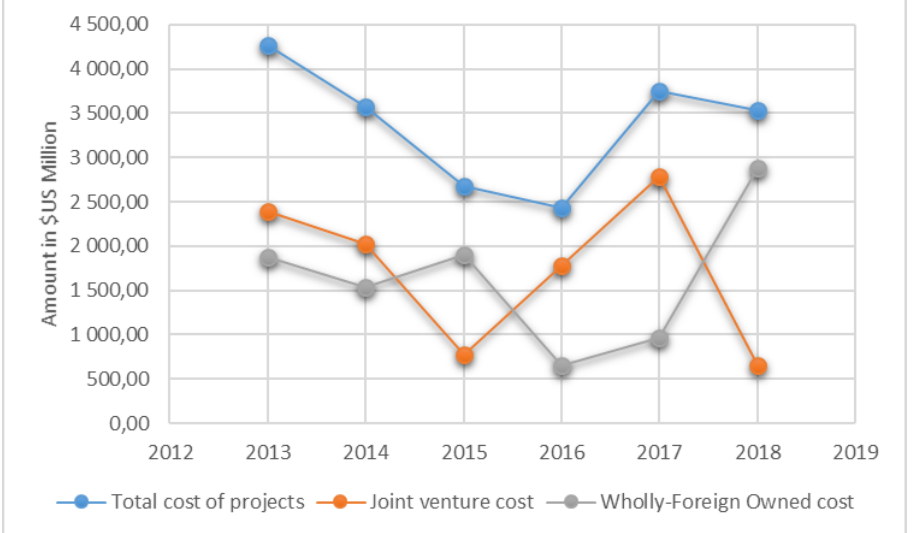
Source : Author’s calculations based on the data from the Ghana Investment Promotion